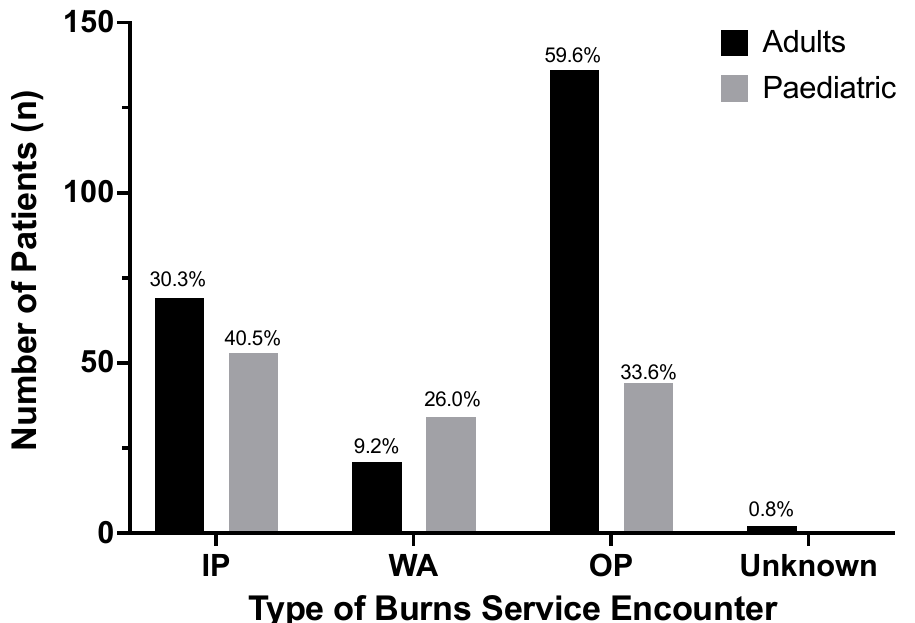
Figure 2. Management of patients with sunburn injury admitted to Manchester adult and paediatric burn centres between 2010–2019 (inclusive). % of cohort shown above bar ( n = 288 (adults), 131 (paediatric)).